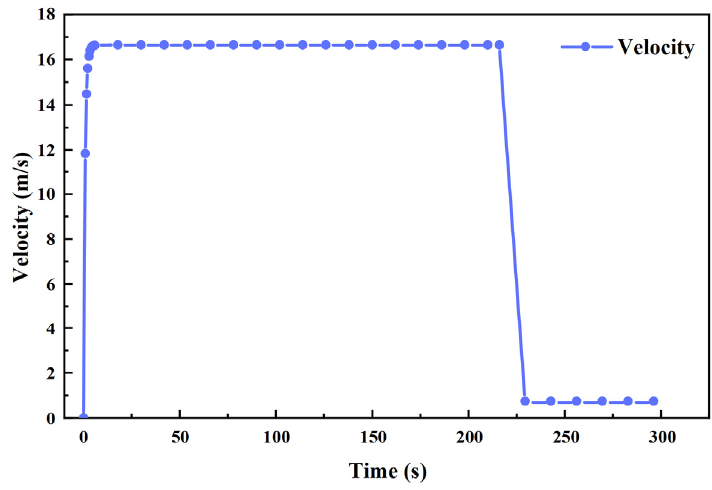
Figure 9. Variation in the downward velocity of the plunger.